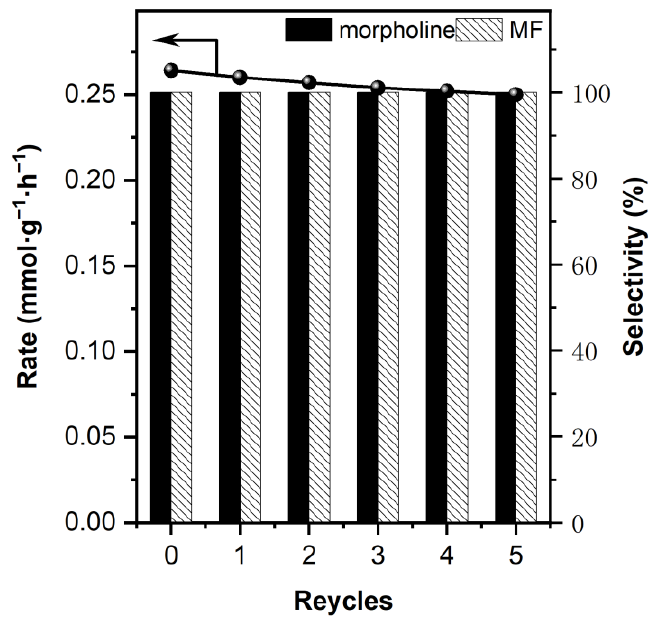
Figure 7. Stability of 13.5% CaO/MgO catalyst in the alcoholysis reaction of NFM during five repeated cycles. Reaction conditions: 0.3 g catalyst, 1.0 mmol NFM, 120 °C, 15 mL methanol.